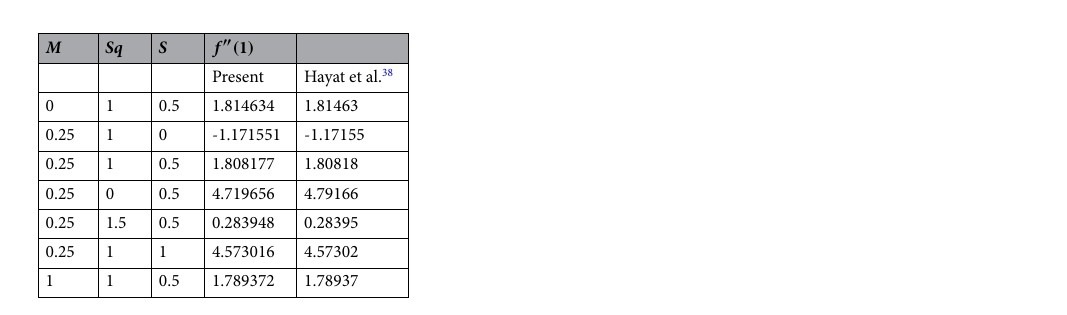
Table 5. Comparative values of f ′′ ( 1 ) -upper plate when (cid:31) = 1 and φ 1 , φ 2 ≈ 0 with various S , Sq and M .